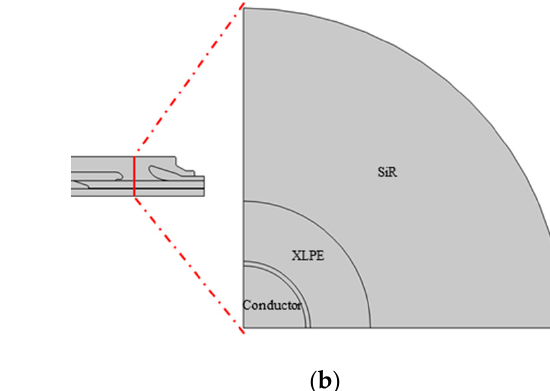
Figure 3. Geometry of the cable joint for simulation: ( a ) The two-dimensional axisymmetric cable joint; ( b ) Cross section of the joint used for thermal mechanical analysis.